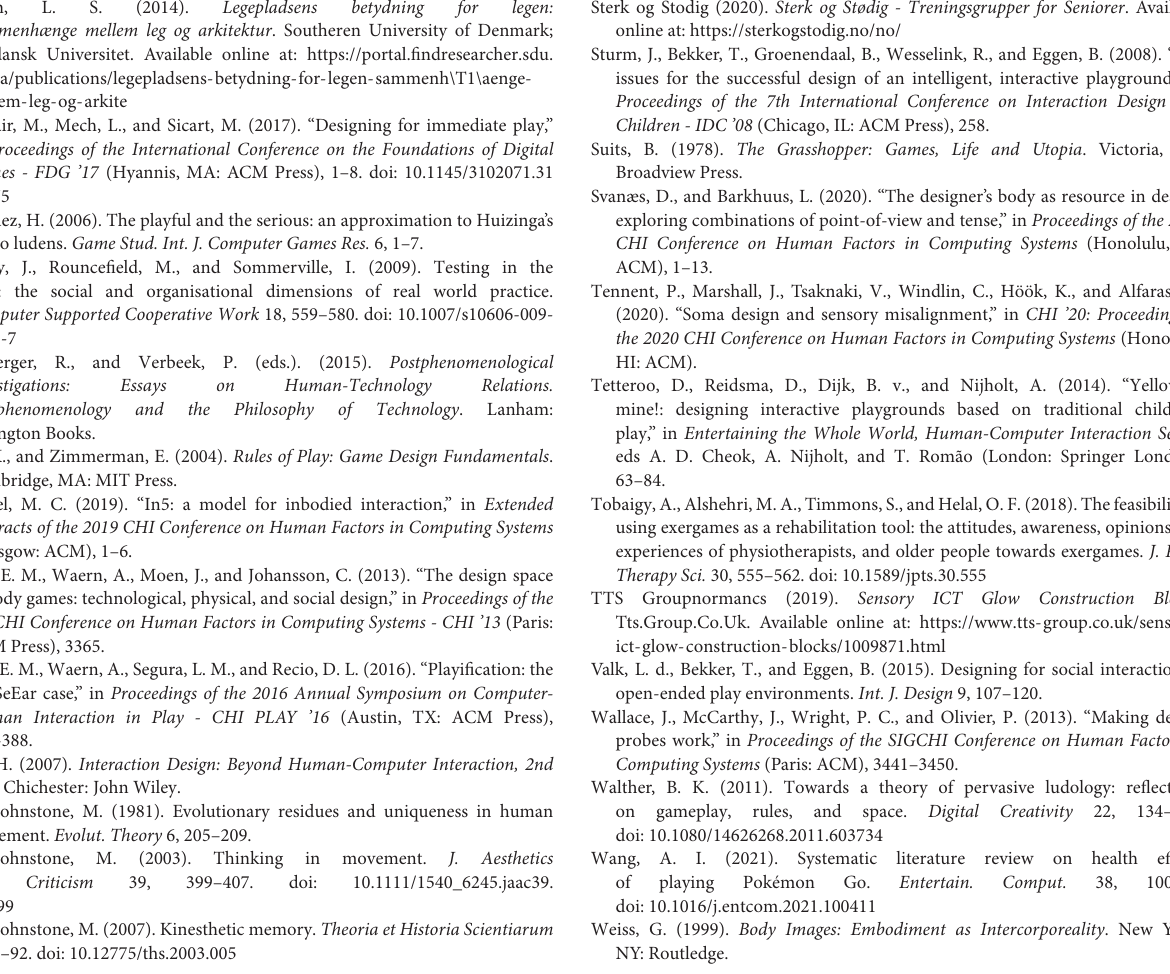
Legepladsens betydning for legen: Sammenhænge mellem leg og arkitektur . Southeren University of